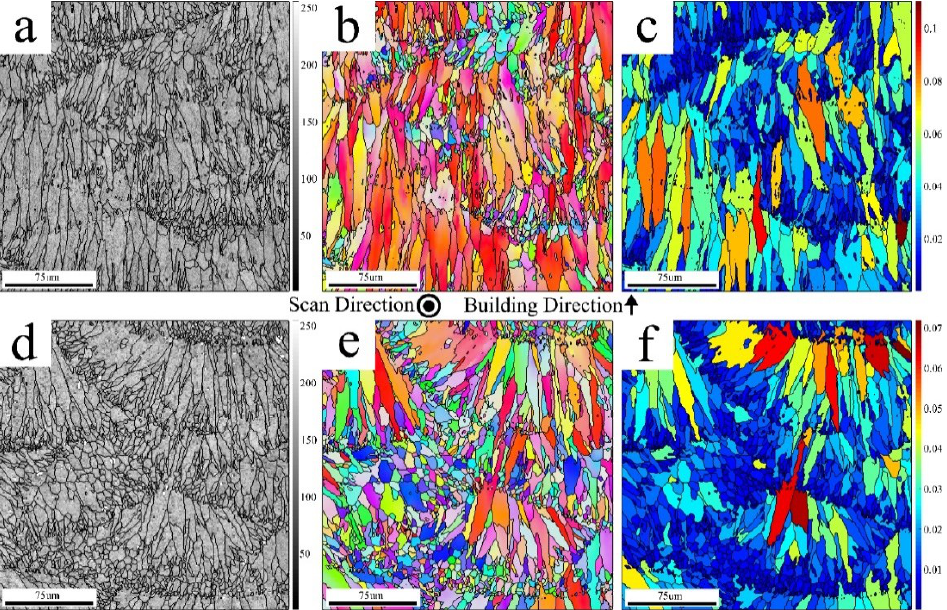
Figure 8. Side view of the SLM–AlSi10Mg samples manufactured by ( a–c ) CL and ( d–f ) EOS, indicating ( a , d ) BC, ( b , e ) IPF (||BD), and ( c , f ) grain orientation spread (GOS) maps, respectively. GOS values are located on the right side of each GOS map.